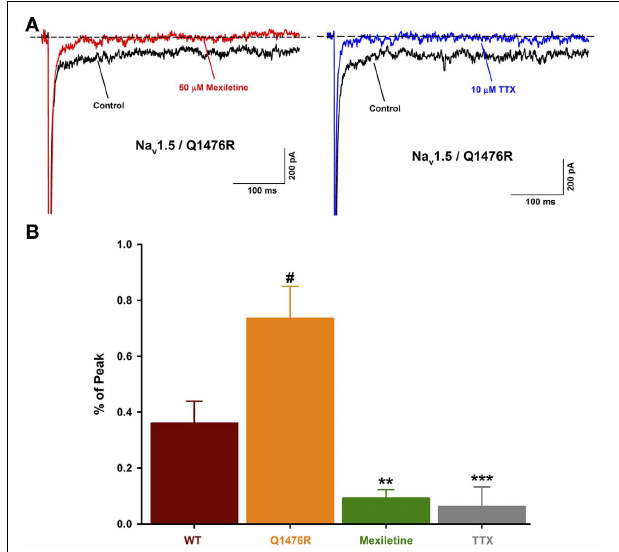
FIGURE 6 | Effect of Na + channel blockers on the INap. (A) Representative current traces obtained after a − 30mV depolarizing pulse showing INap before and after drug treatment. The Na v 1.5/Q1476R traces are depicted in black while the traces after treatment are shown in red for mexiletine (50 μ M, left) and blue for TTX (10 μ M, right). (B) Histogram of INap. The INap accounted for 0 . 36 ± 0 . 08% ( n = 13, red column) of the peak current for WT channel and 0 . 74 ± 0 . 11% ( n = 14, orange column) for Q1476R channels ( # p = 0 . 015 when compared to WT channels). The treatment with 50 μ M of mexiletine or 10 μ M of TTX, respectively reduced the INap to 0 . 09 ± 0 . 03% ( n = 5, green column, ∗∗ p = 0 . 002) and 0.06 ± 0.06% ( n = 5, gray column, ∗∗∗ p = 0 . 001). After treatment, no differences were observed with WT channels. “#” indicate statistical differences when compared to WT channels, “ ∗ ” indicate statistical differences when compared to Q1476R